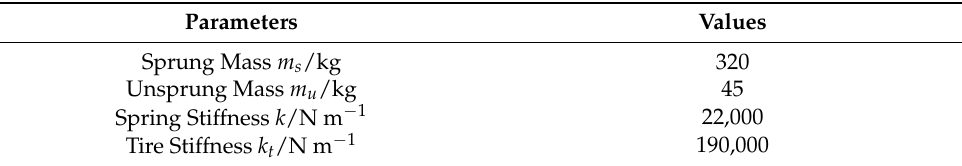
Figure 2. A quarter vehicle suspension model. Table 2. Parameters of quarter vehicle suspension model. Parameters Values Sprung Mass m s /kg